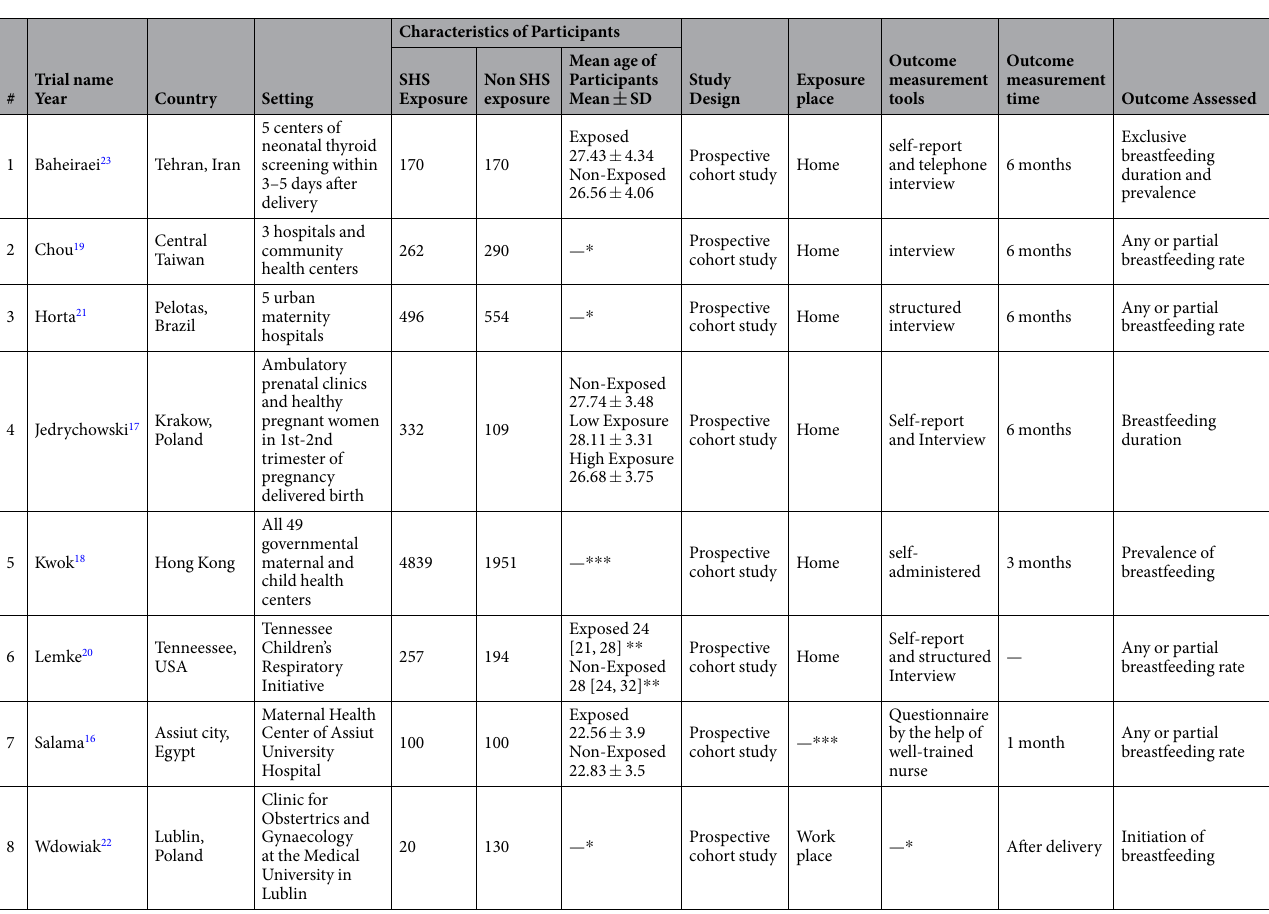
Table 1. Characteristics of the included studies. * Data was shown by category. Mean age not described. ** Median [IQR]. *** Not